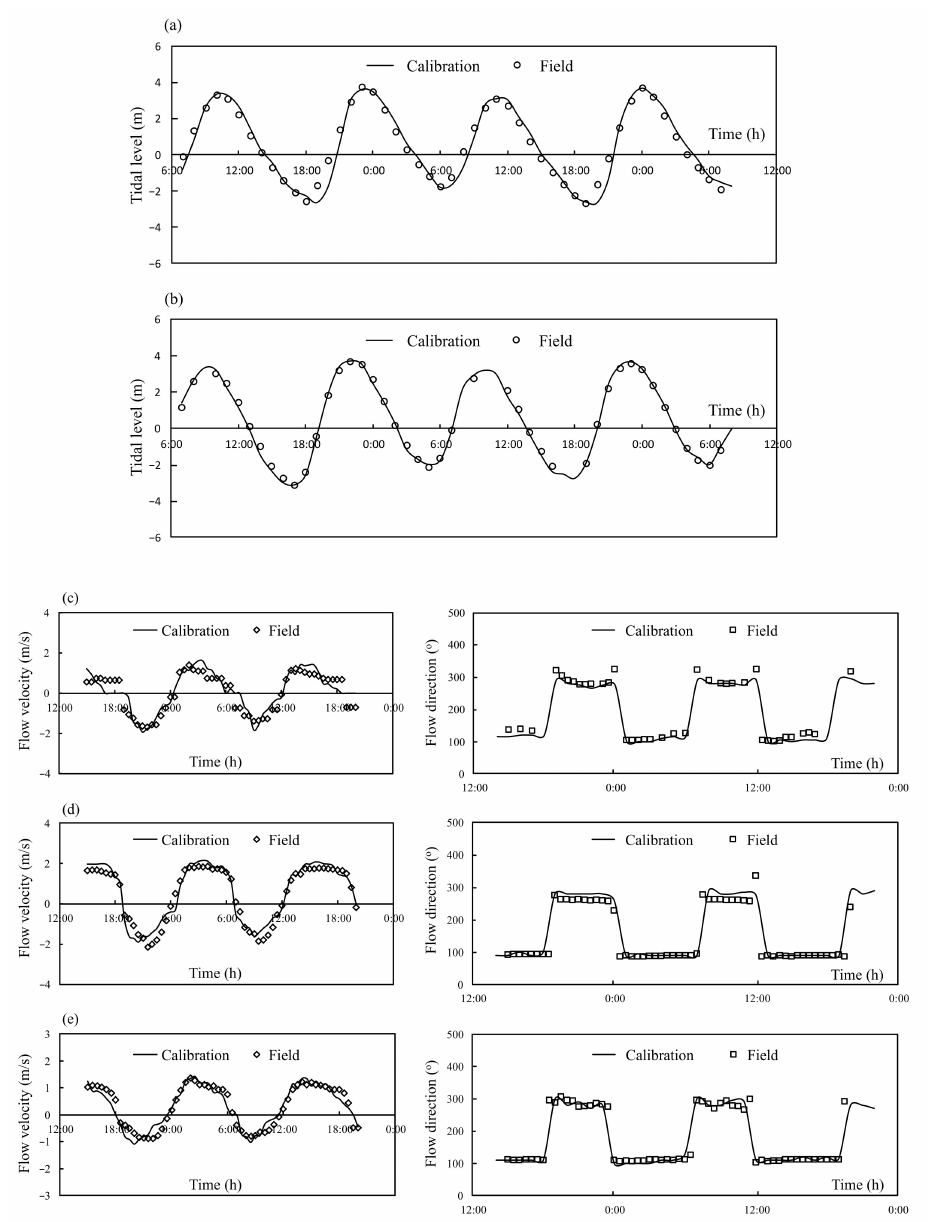
Figure 3. Model calibration: tidal level ( a ) W1 and ( b ) W2; flow velocity and direction ( c ) C1, ( d ) C2, and ( e ) C3. The locations of the calibration points are shown in Figure